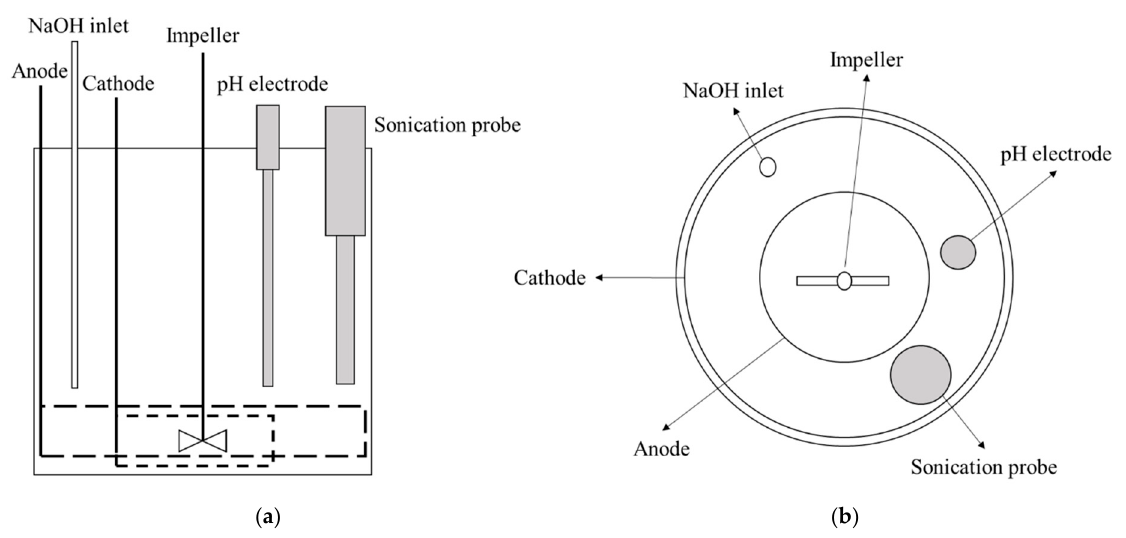
Figure 1. The configuration of cell for leaching. ( a )side view ( b ) top view During all experiments, the reaction mixture was sampled at the desired time, fil- tered, and analyzed for the concentration of metal ions using the inductively coupled plasma-atomic emission spectrometer (ICP-AES, iCAP6000, Thermo Fisher, Cambridge, UK).